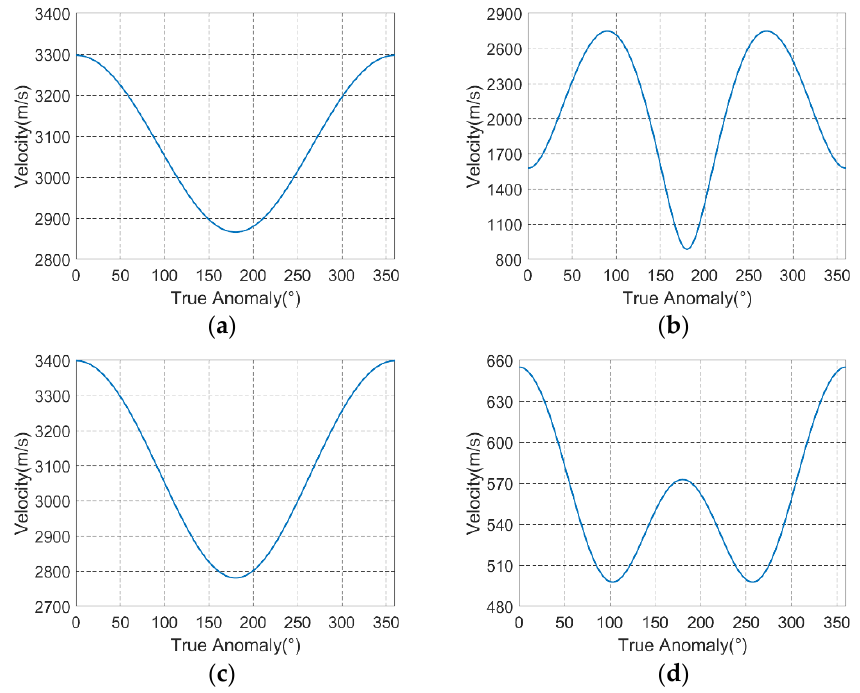
Figure 3. GEO SAR velocity. ( a ) “8” shaped orbit in ECI; ( b ) “8” shaped orbit in ECEF; ( c ) Near- circular orbit in ECI; and ( d ) Near-circular orbit in ECEF.